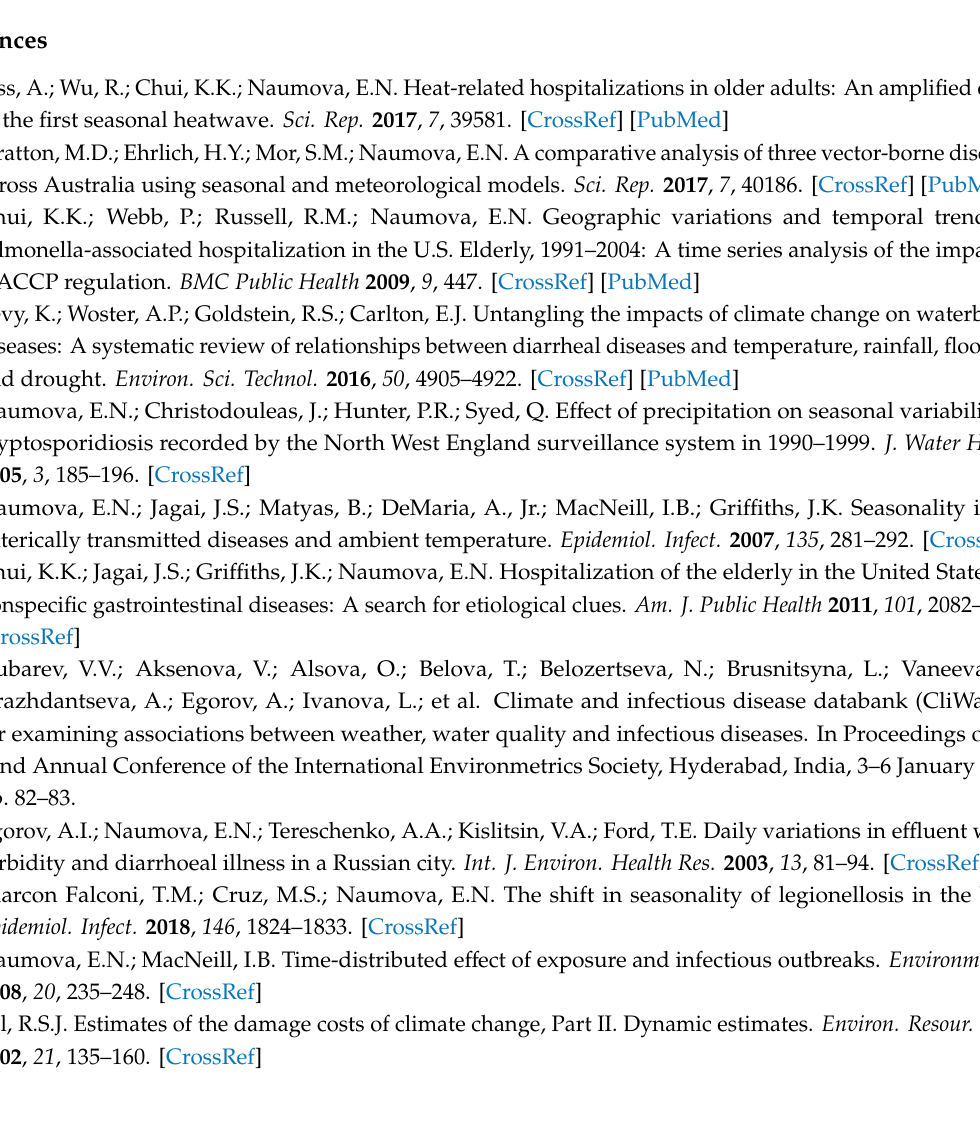
Table S1. The daily counts of health outcomes and average daily values of temperature ( ◦ C), atmospheric pressure (hPa), relative humidity (%) and dew point ( ◦ C) from 1 January 2004 to 15 November